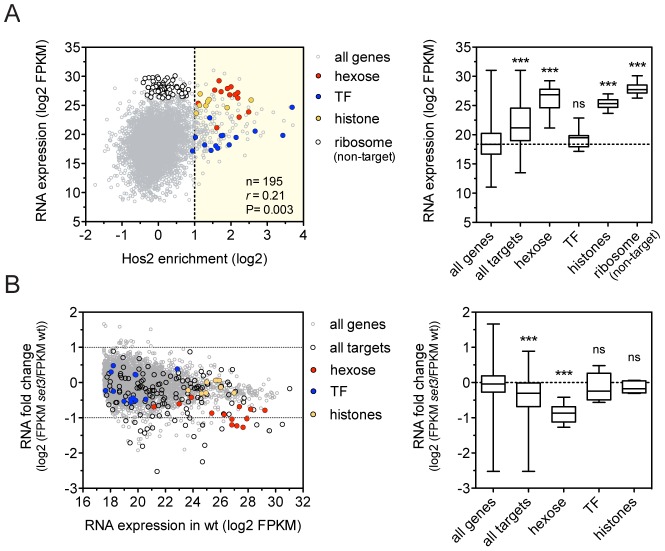
The Set3C decorates highly transcribed genes.(A) Correlation of Set binding and RNA expression for the target gene set (defined on Figure 1D). Each dot corresponds to one gene. The distribution of expression values of the genes belonging to each functional category is shown on the right panel. “r” denotes a Pearson's correlation coefficient. TF stands for the transcription factor cluster (see text). Statistical significance was determined by the Mann-Whitney U-test relative to the “all genes” set. *P<0.05, **P<0.01, ***P<0.001, ns: not significant. (B) Transcript profile of set3Δ/Δ cells by RNA-Seq. The fold change in RNA expression between set3Δ/Δ and wild type cells at each gene is plotted against the expression level of the gene in wild type cells. The direct binding targets and their functional groups are highlighted. The distribution of fold changes of the genes belonging to each functional category is shown on the right panel. Statistical significance was determined by the Mann-Whitney U-test relative to the “all genes” set. *P<0.05, **P<0.01, ***P<0.001, ns: not significant.